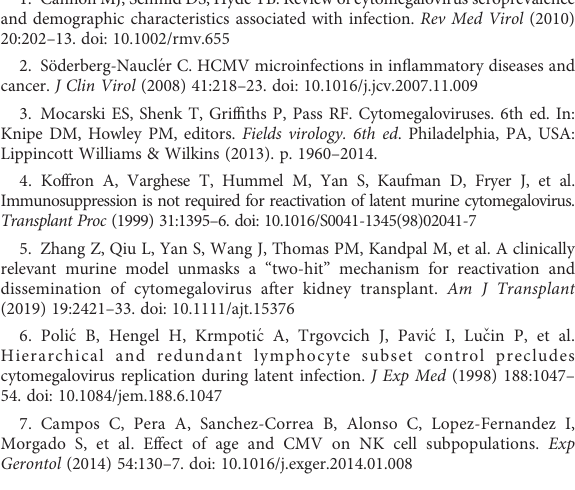
SUPPLEMENTARY TABLE 1 Virus mutants used in studies. SUPPLEMENTARY TABLE 2 Primers used for